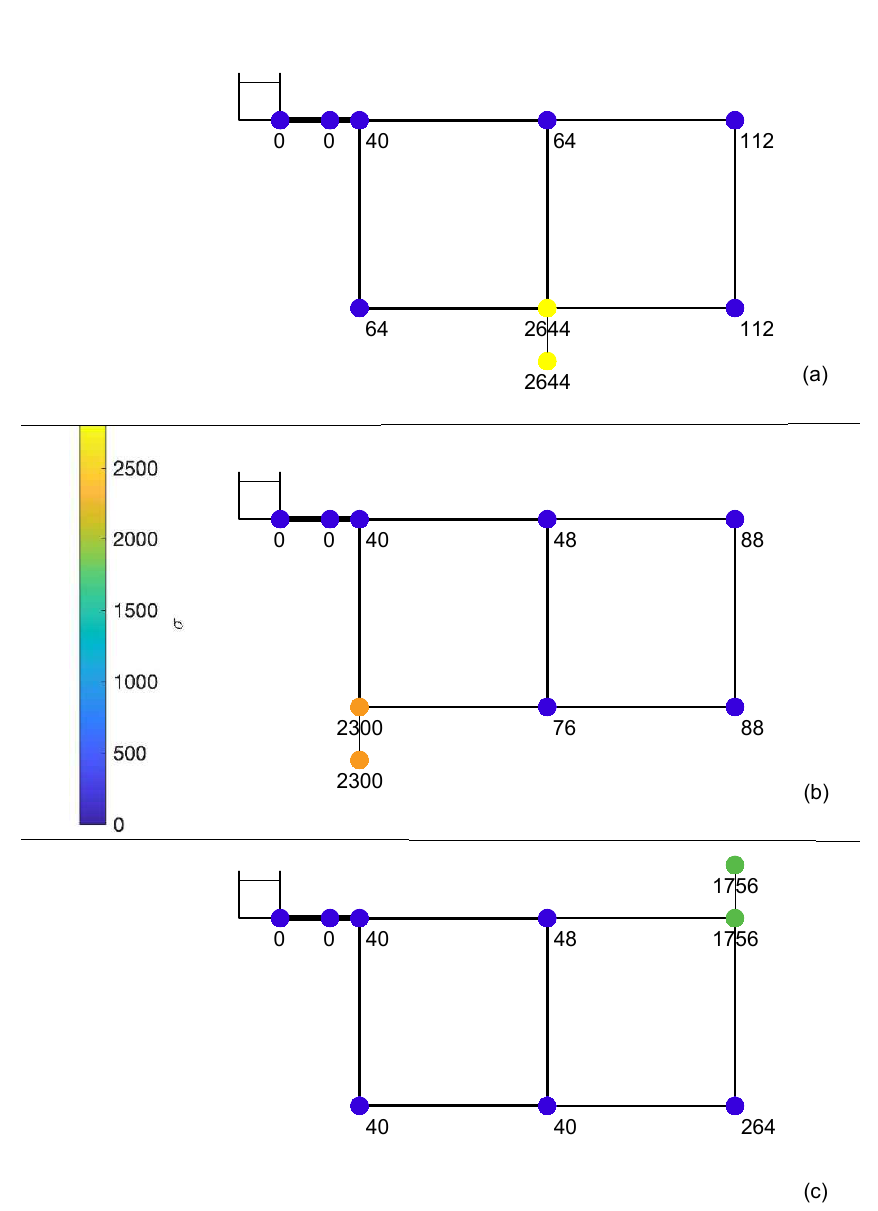
Figure 9. Map of vulnerability evaluated by the LM for tests: ( a ) #1; ( b ) #2; and ( c ) #3; respectively (numbers at nodes indicate the value of the index of vulnerability, V